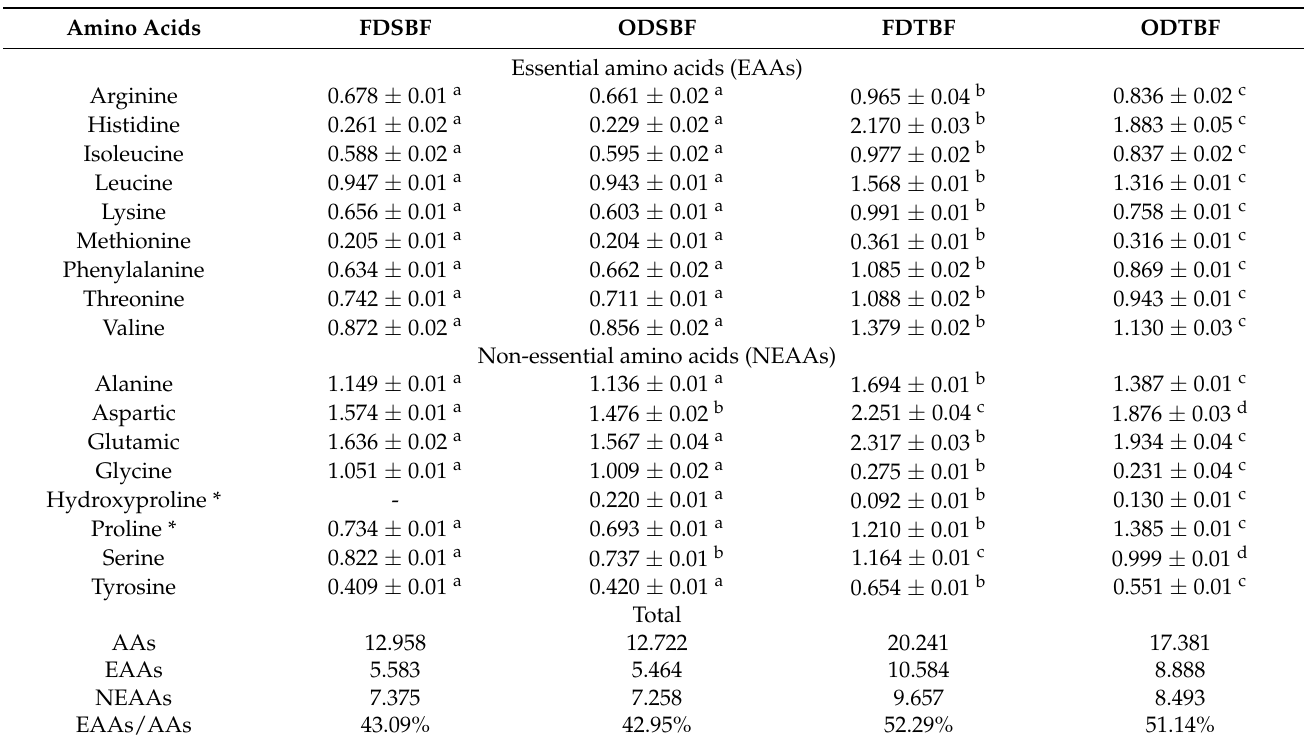
Table 2. T -test results (multiple comparisons) of the amino acids of biofloc (g/100 g) from two waste sources (shrimp and tilapia) and two methods of drying (freeze-drying and oven-drying).